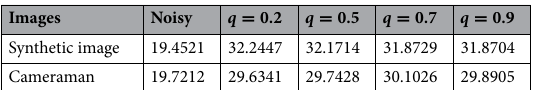
Table 1. PSNR for NTVL1 model with different penalty